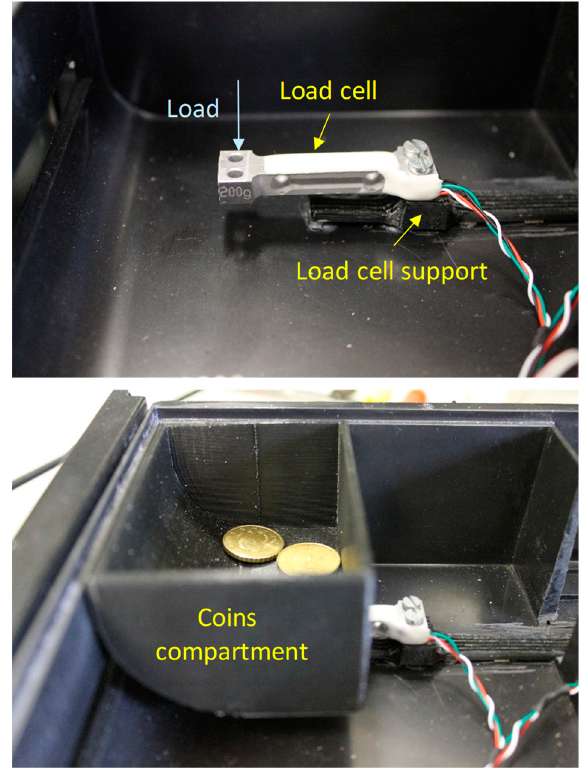
Figure 1. Load cell mount ( top ) and coins compartment assembly ( bottom ).